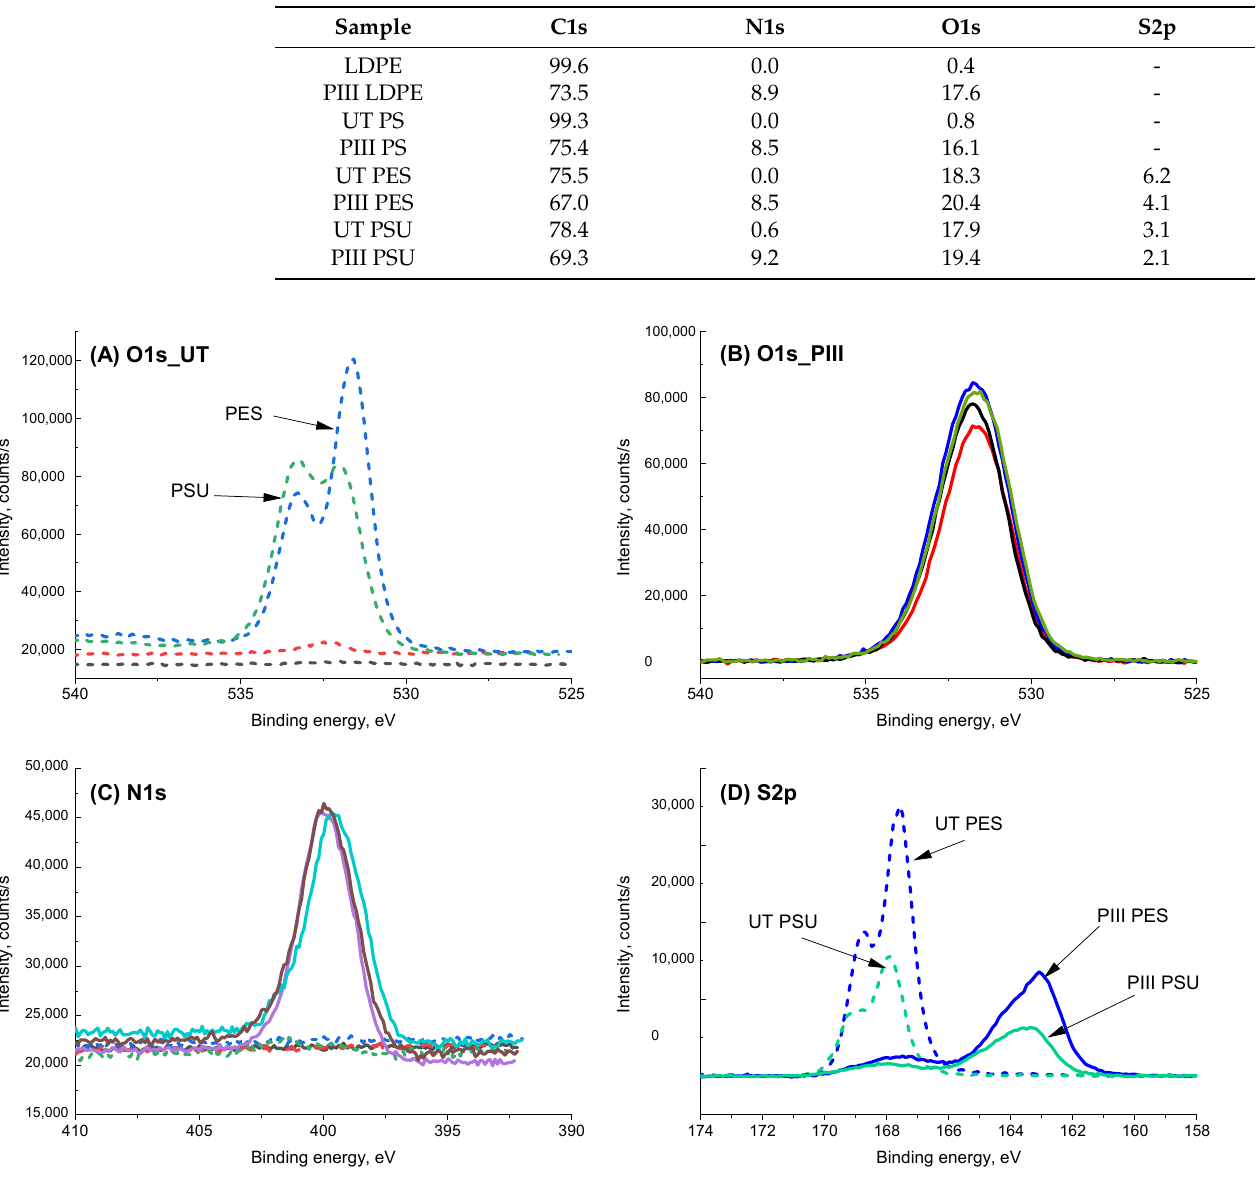
Table 1. Atomic percentages of elements detected on polymer surfaces using XPS.